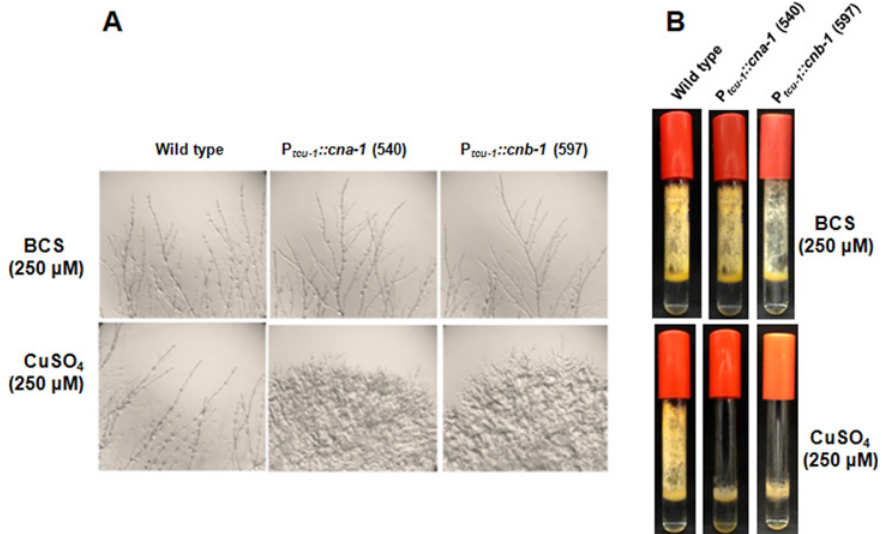
Fig 3. Effect of reduced expression of calcineurin on hyphal growth. (A) Hyphal morphology . The wild type, Δ cna-1 :: hph; Δ pan-2 ::P tcu-1 :: cna-1 :: v5 :: gfp; mat a (540), and Δ cnb-1 :: hph; Δ pan-2 :: P tcu-1 :: cnb-1 :: v5 :: gfp; mat a (597) strains were cultured on VM medium supplemented with 250 μ M of BCS (upper panel) or CuSO 4 (lower panel) for 24 h at 30°C and then photographed using a Canon G10 camera with an Olympus SZX9 stereo microscope. (B) Aerial hyphae growth. Wild type, Δ cna-1 :: hph; Δ pan-2 :: P tcu-1 :: cna-1 :: v5 :: gfp; mat a (540), and Δ cnb-1 :: hph; Δ pan-2 ::P tcu-1 :: cnb-1 :: v5 :: gfp; mat a (597) strains in VM liquid medium supplemented with 250 μ M of BCS (upper panel) or CuSO 4 (lower panel). Strains were grown for three days at 30°C in dark and four days under light at room temperature and photographed using a Canon G10 camera.